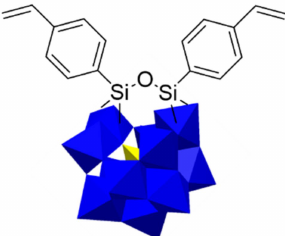
Figure 4. Structure of distyryl modified [SiW 11 O 39 ] 4- via silanization. Reproduced with permission from [58]. Copyright (2019) Elsevier.